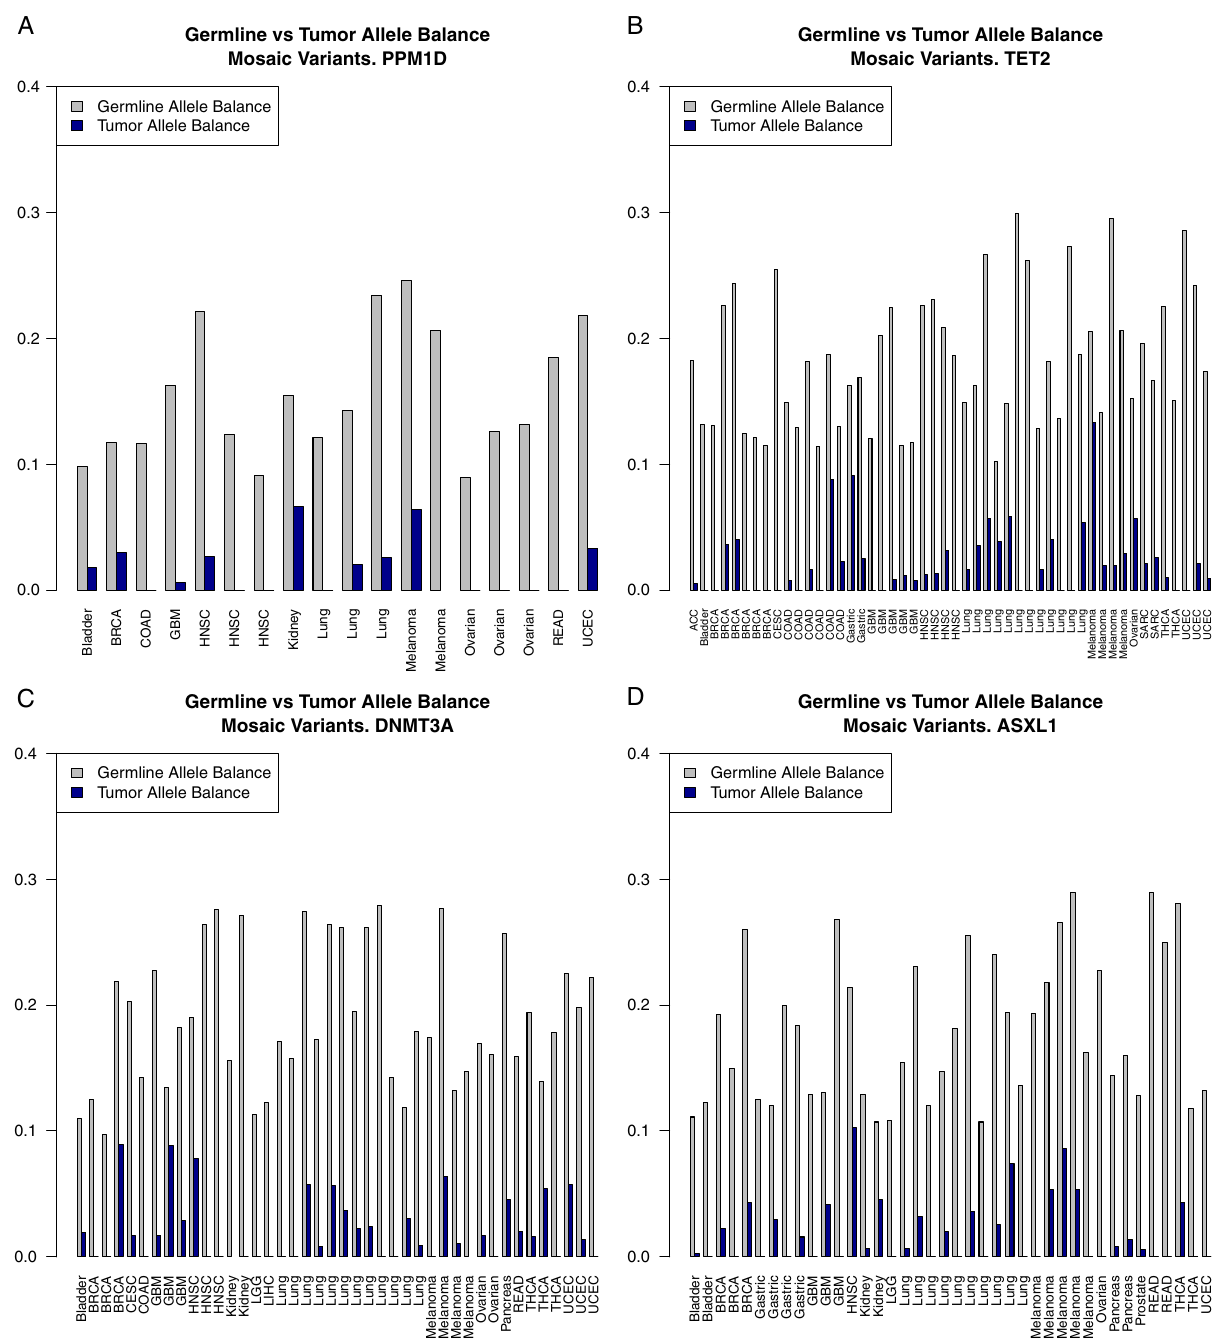
Fig. 1 Blood vs. tumor allele balance for each sample with mosaic PTV in a PPM1D, b TET2, c DNMT3A, d ASXL1. Observed in blood mosaic mutations are strongly depleted from the tumor somatic DNA (Wilcoxon test p < 10 − 16